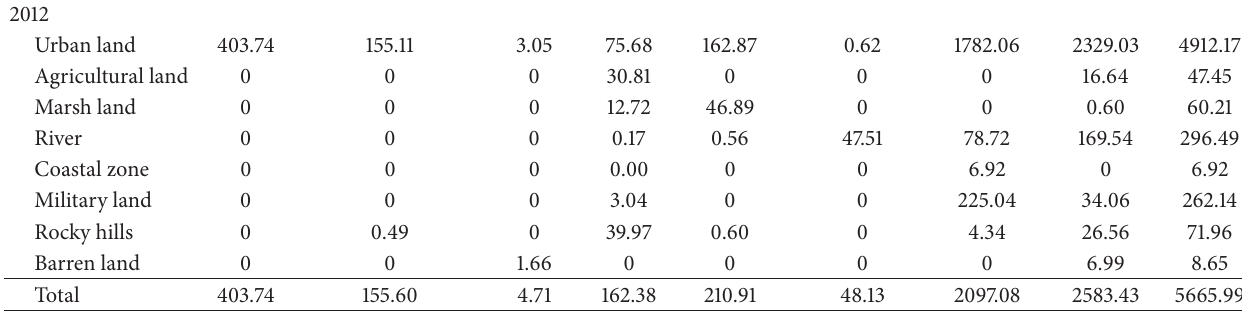
Table 5: Land use/cover matrix, 1956–2012 (hectares).